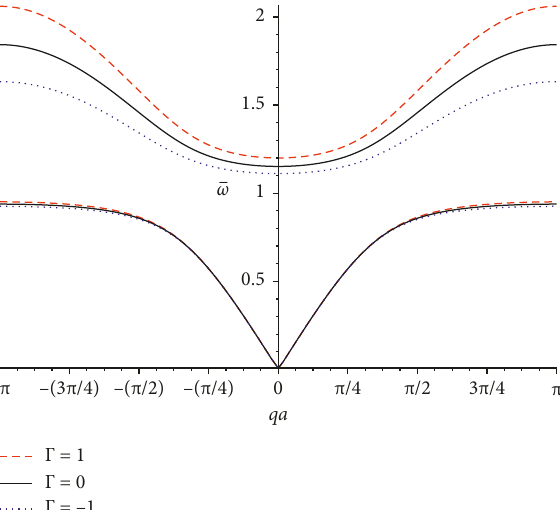
Figure 2: The influence of nonlinear factors on the dispersive